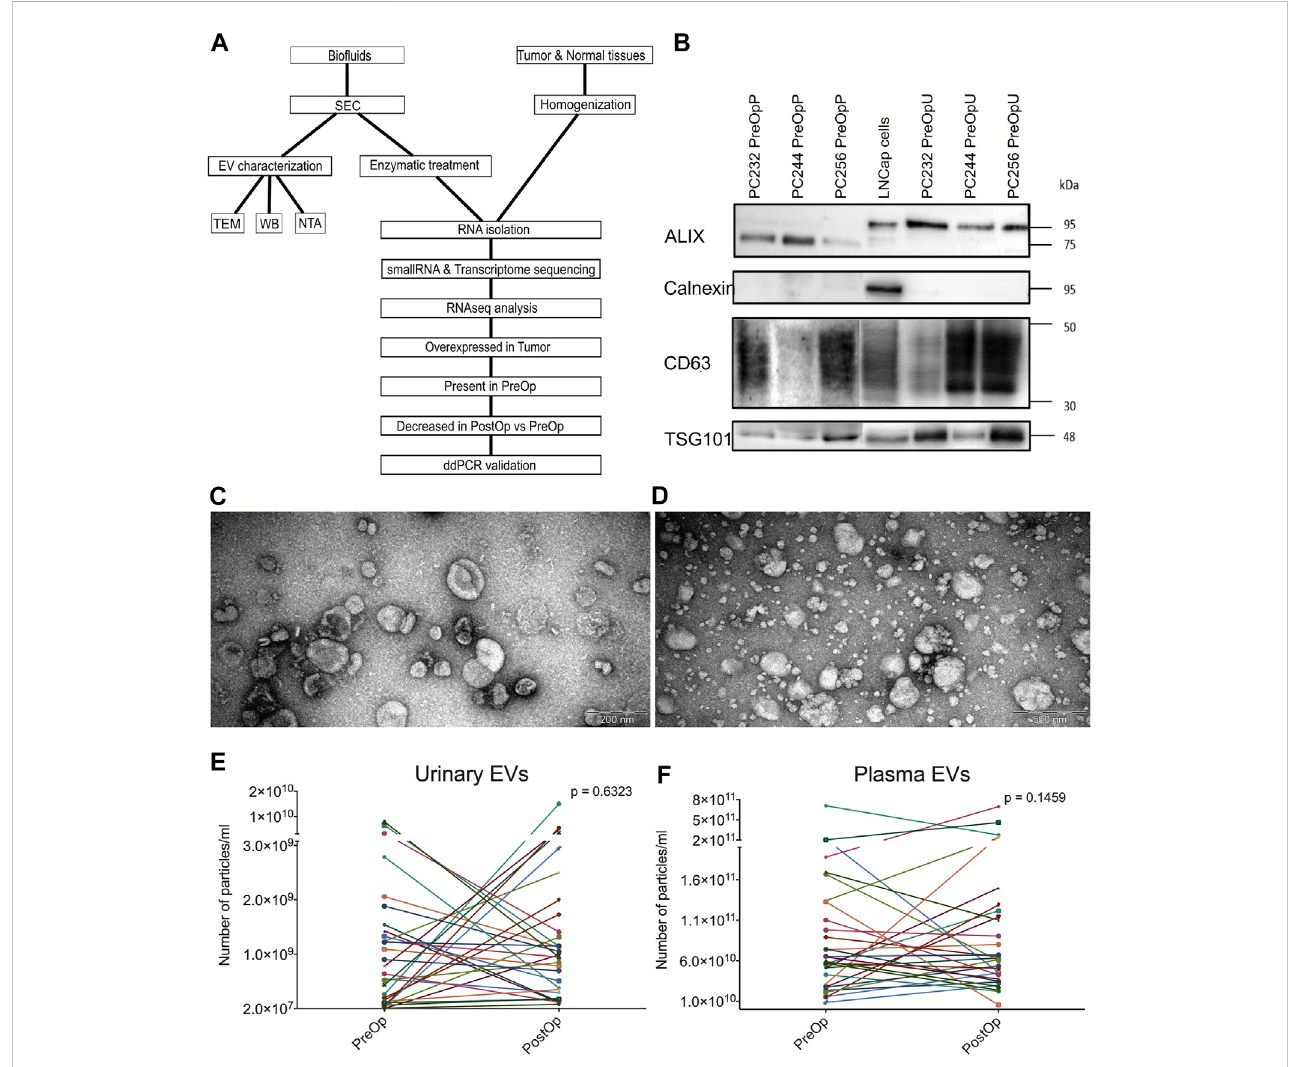
FIGURE 1 EVisolationandcharacterization. (A) Work fl owofthestudy. (B) WesternblotofCD63,ALIX,TSG101andcalnexininLNCaPprostatecancercellsandpre- operation urinary and plasma EVs from three differentpatients. (C) Representative TEM image ofurinary EVs. (D) Representative TEM imageof plasma EVs. (E) Paired dot plots showing the numbers of EVs per ml of urine before (PreOp) and after radical prostatectomy (PostOp). (F) Paired dot plots showing the numbers of EVs per ml of plasma before and after radical prostatectomy. Wilcoxon matched-paired signed rank test was used to assess the statistical signi fi cance of the differences between